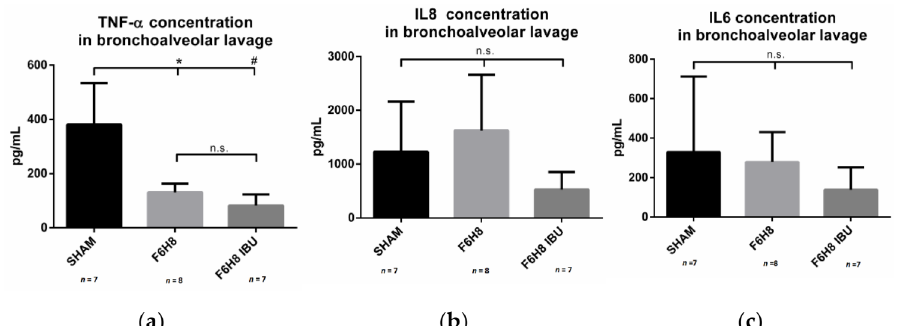
Figure 3. ( a ) TNF- α concentration in lung fluid after bronchoalveolar lavage: a significantly higher TNF- α concentration was observed in the sham group when compared to the F6H8 group (* p = 0.006) and F6H8-ibuprofen group (# p = 0.001). There was no significant difference in the TNF- α con- centrations between the two additional groups. ( b ) IL-8 lung fluid concentration: no statistical difference was observed between the groups; however, a trend was observed toward a lower IL-8 level in the ibuprofen treatment animals. ( c ) IL-6 lung fluid concentration: no statistical difference was observed between the groups; but again, a trend was observed toward a lower IL-6 level in the ibuprofen-treated